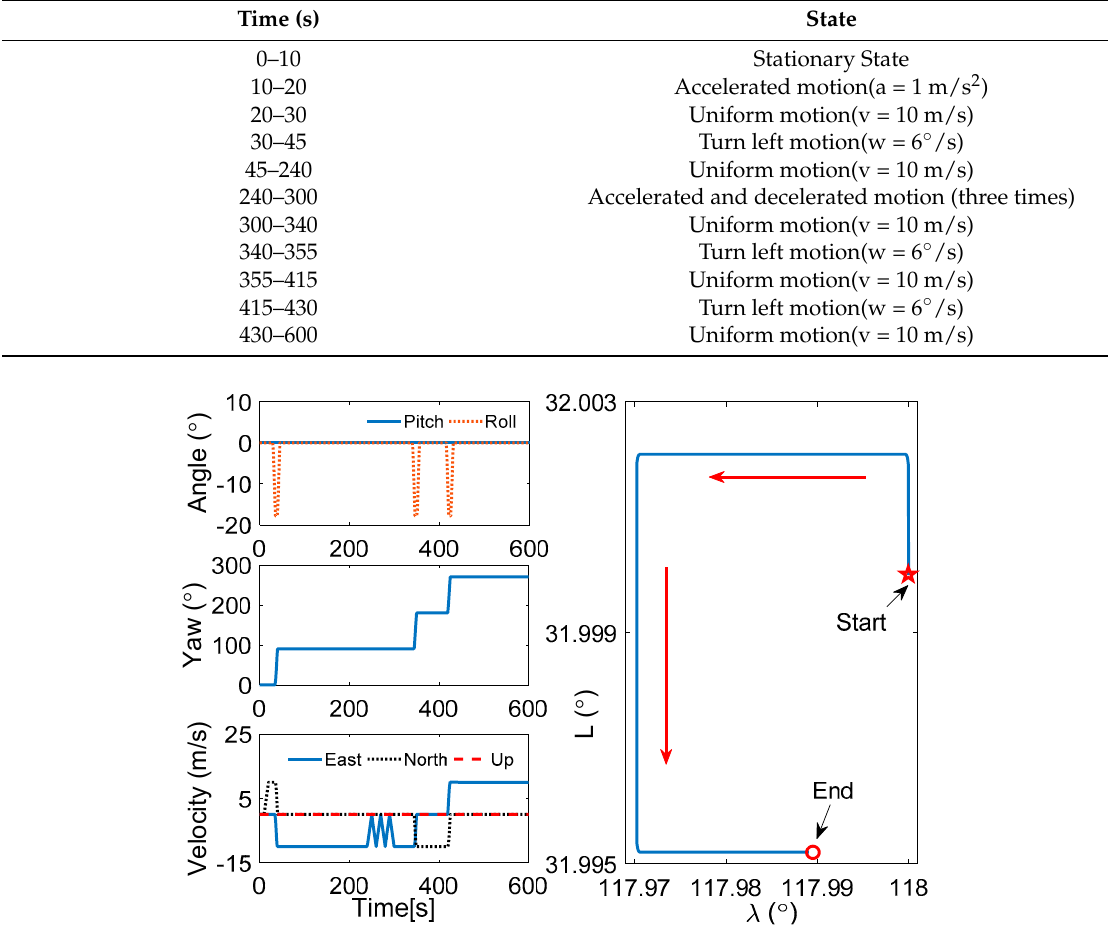
Figure 9. Curves of vehicle motion.